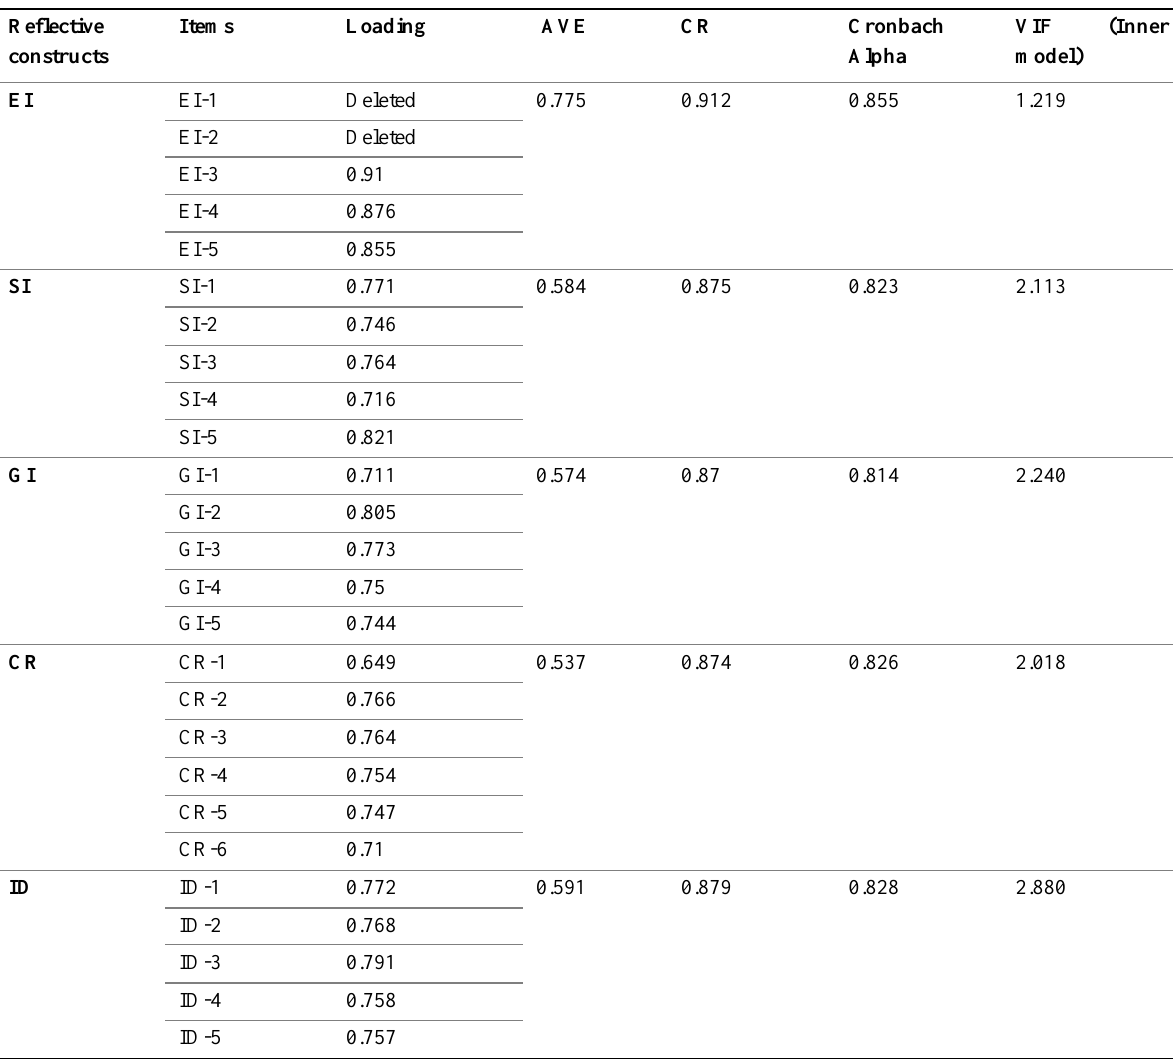
Table 1: Outer loading, AVE, CR, Cronbach Alpha, and